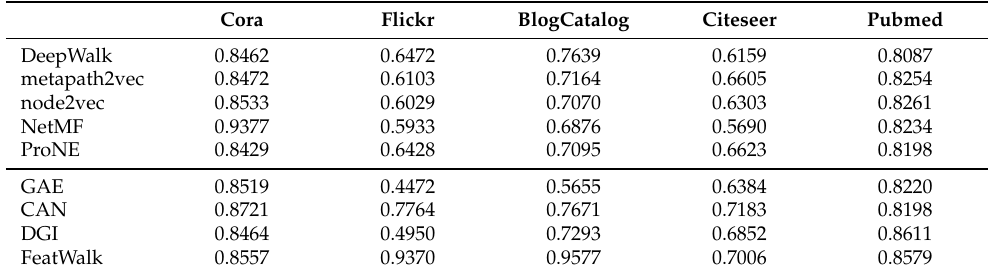
Table 10. Results in Task 1 using TPE to tune hyperparameters, in terms of macro-averaged F1. Cora Flickr